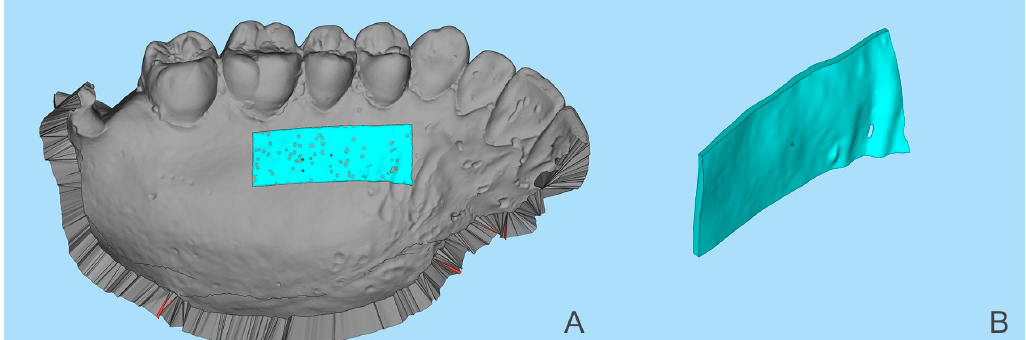
Figure 4. ( A ) Superimposed STL files of T0 and T1 with the region of interest (ROI) highlighted. ( B ) Region of interest with the volume alterations (VA) measured in mm 3 .